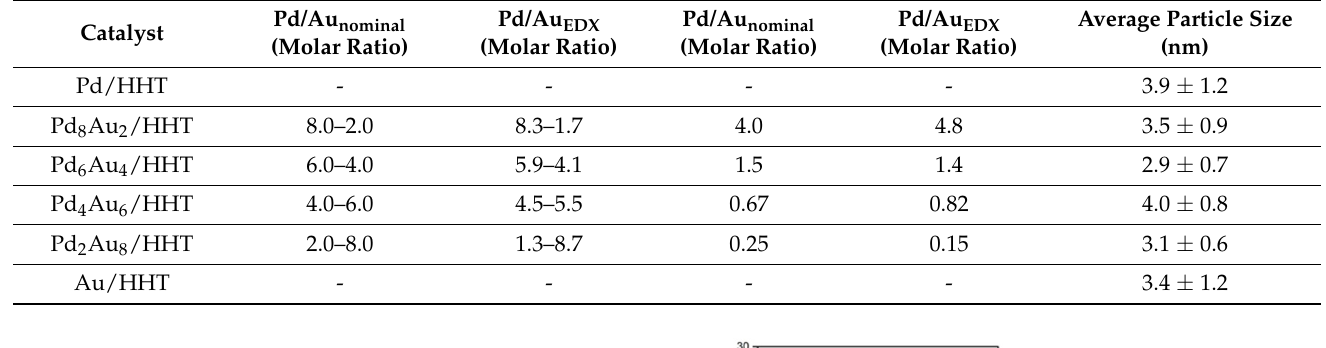
Table 1. Results of TEM-EDX analysis.